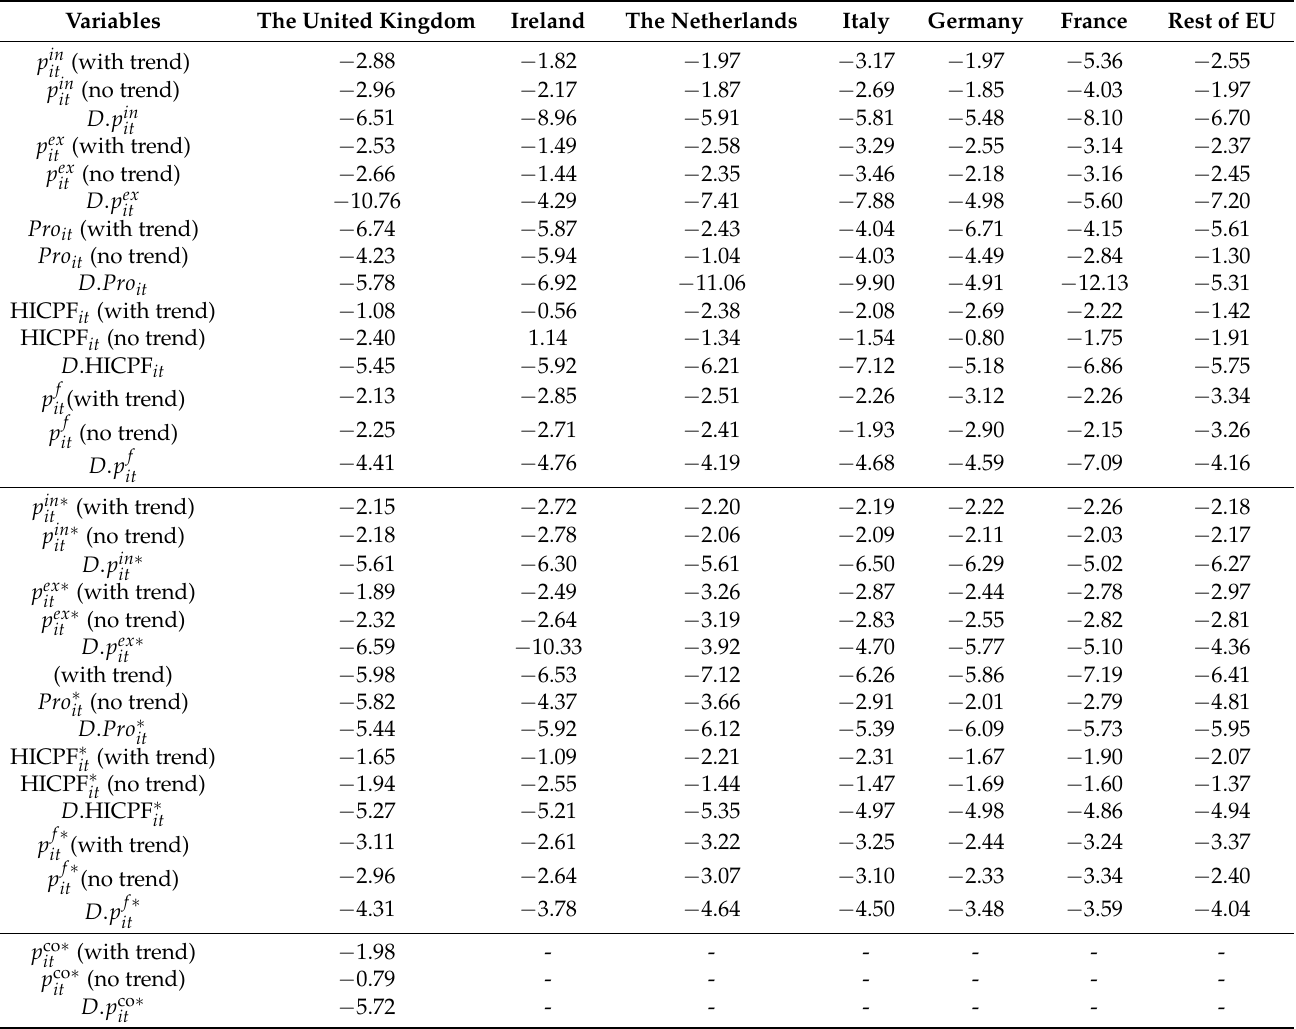
Table 2. Augmented Dickey–Fuller (ADF) unit root test statistics for domestic and foreign variables.